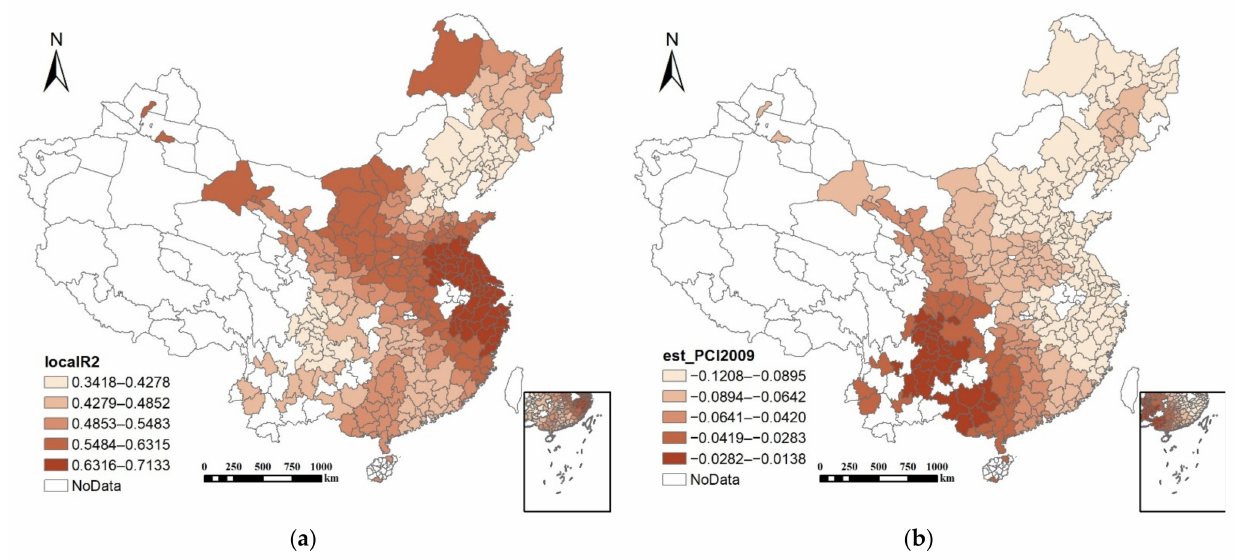
Figure 6. Spatial patterns of local R 2 and coefficients for PCI in the GWR model. ( a ) Local R 2 , ( b ) local coefficients of PCI.